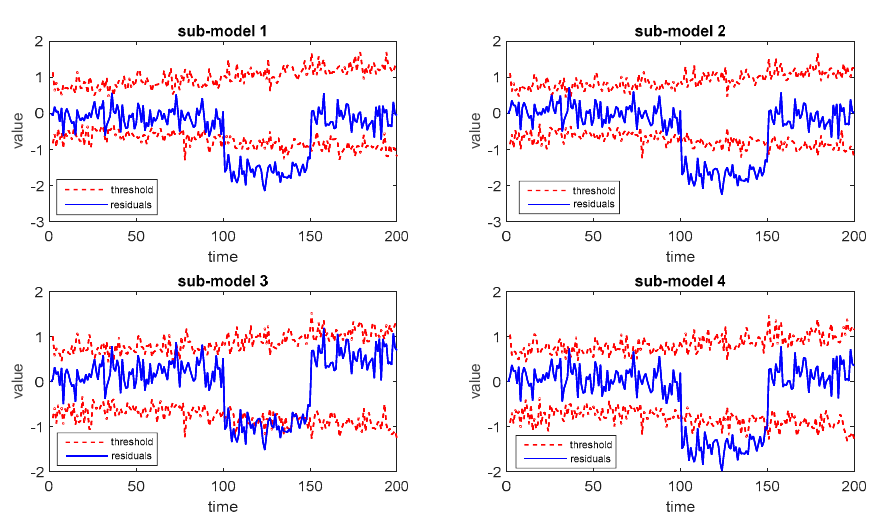
Processes 2020 , 8 , 164 Figure 5. Monitoring results of fault 1 in numerical example. Figure 5. Monitoring results of fault 1 in numerical example.